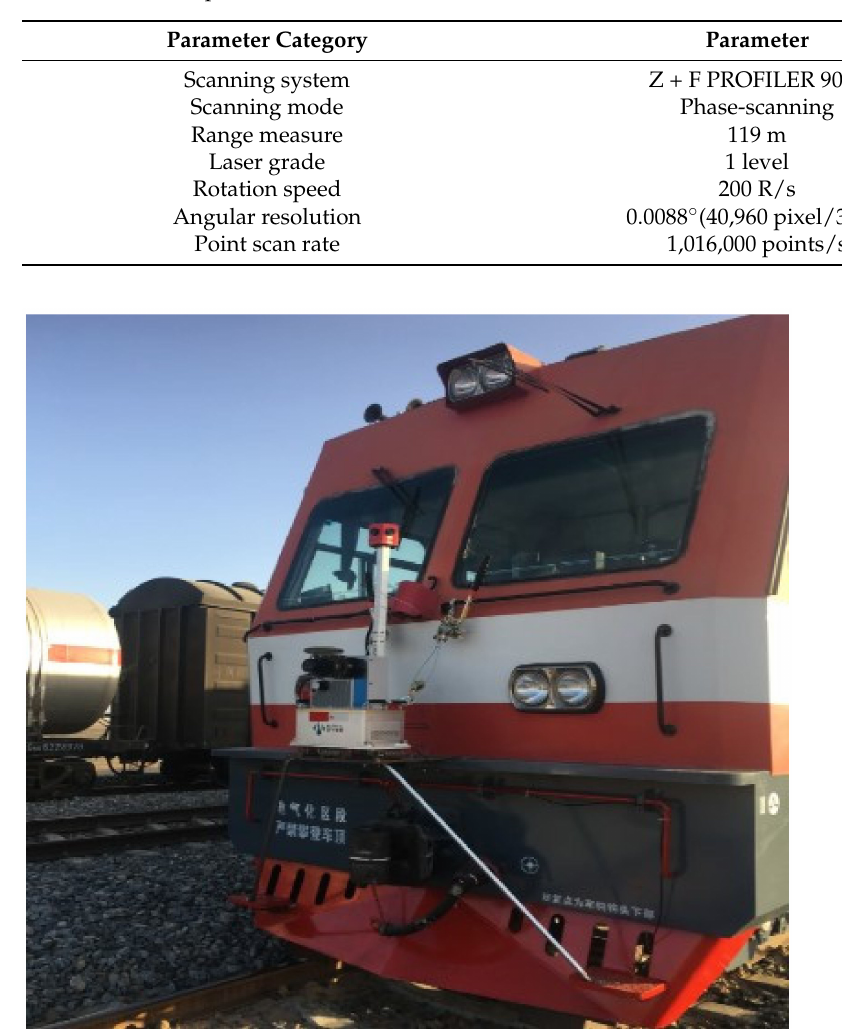
Figure 4. Vehicle-mounted LiDAR and its installation location.